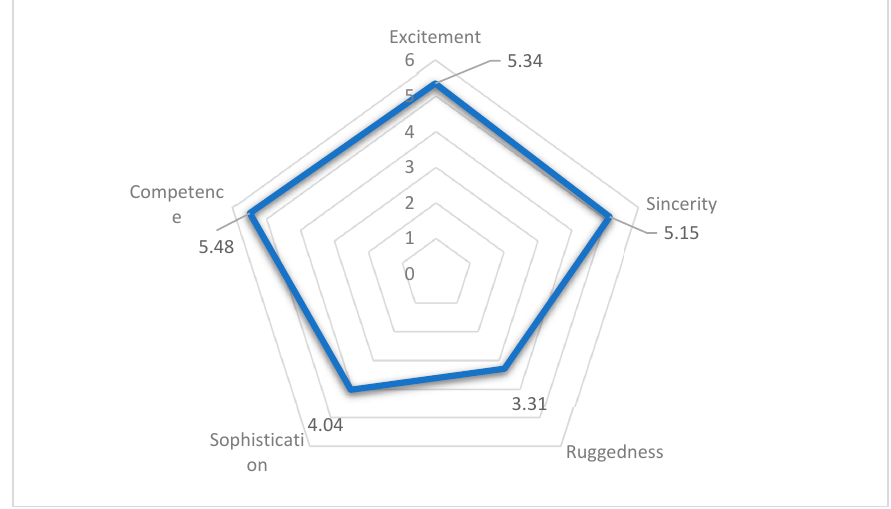
Figure 4. Airbnb brand personality dimensions. Table 6. Regression testing results. Brand personality dimensions and consumer